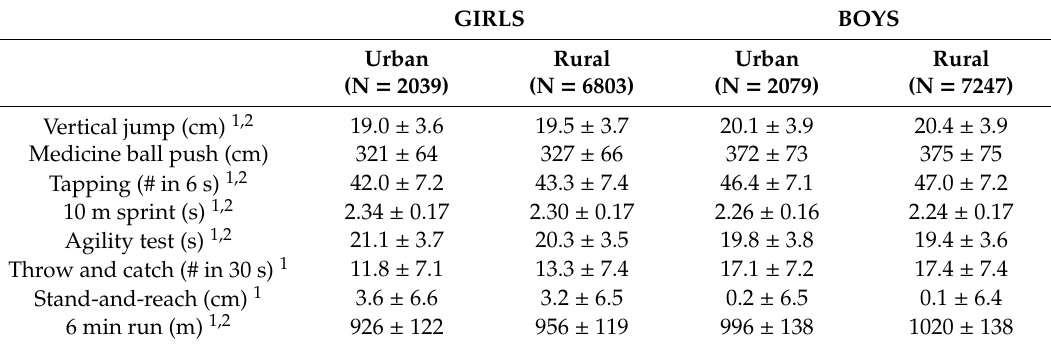
Table 2. Physical fitness by living area separately for girls and boys. Values are mean ± SD.